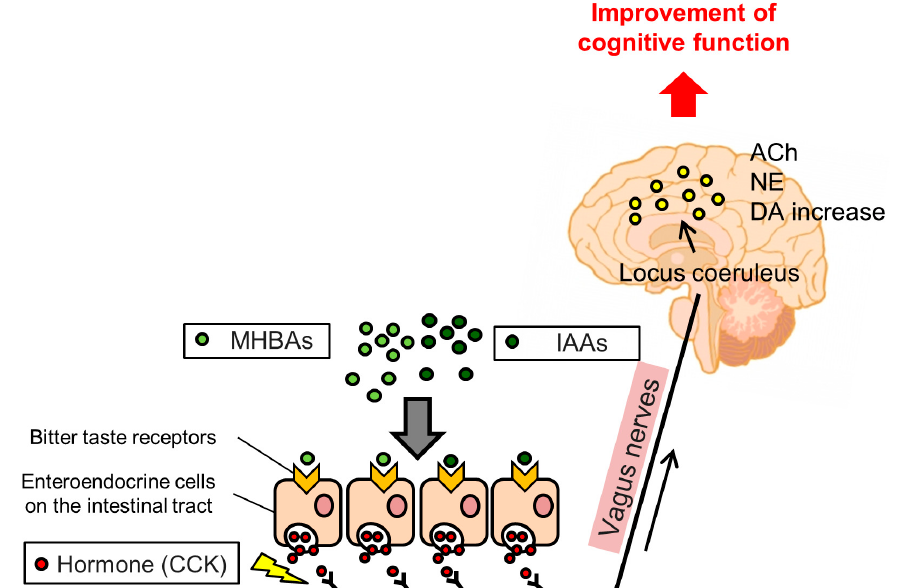
Figure 3. Expected mechanism underlying the memory improvement effects of Iso- α -acids (IAAs) and Matured hop bitter acids (MHBAs). IAAs and MHBAs may bind to bitter taste receptors in the